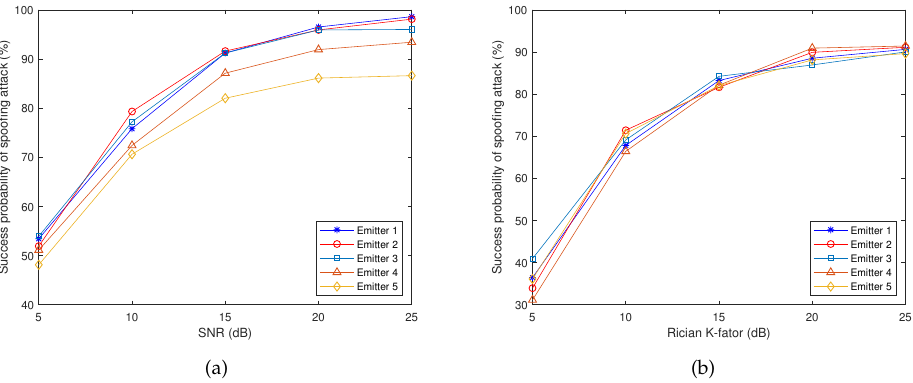
Figure 11. The success probability of spoofing attack versus ( a ) SNR and ( b ) Rician K -factor for multiple